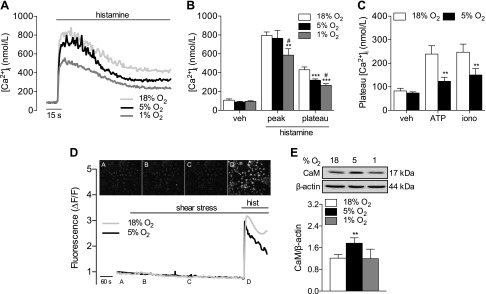
Attenuated Ca2+ mobilization in human endothelial cells cultured in various levels of O2. HUVECs were maintained at 18% O2 or cultured in 5 or 1% O2 for at least 5 d. Cells were stimulated with histamine (10 µM), and [Ca2+]i was monitored. A) Ca2+ transients in HUVECs stimulated with histamine (10 µM) in 18, 5, or 1% O2. B) Average peak and plateau [Ca2+]i values in response to histamine. C) Plateau [Ca2+]i levels in response to ATP (10 µM) or ionomycin (0.1 µM). D) HUVECs were loaded with Cal520-AM and then exposed to 15 dyn/cm2 unidirectional shear stress for 10 min, followed by an acute stimulation with histamine. Representative images are provided from HUVECs at 18% O2. E) Calmodulin (CaM) expression in HUVECs in 18, 5, or 1% O2. Representative immunoblots and analysis of CaM expression relative to β-actin. Treatment with histamine was significant (P < 0.05 vs. respective control) in relevant panels. Data are means ± sem (n = 4–11 different donors). **P < 0.01, ***P < 0.001 vs. 18% O2; #P < 0.05 vs. 5% O2.